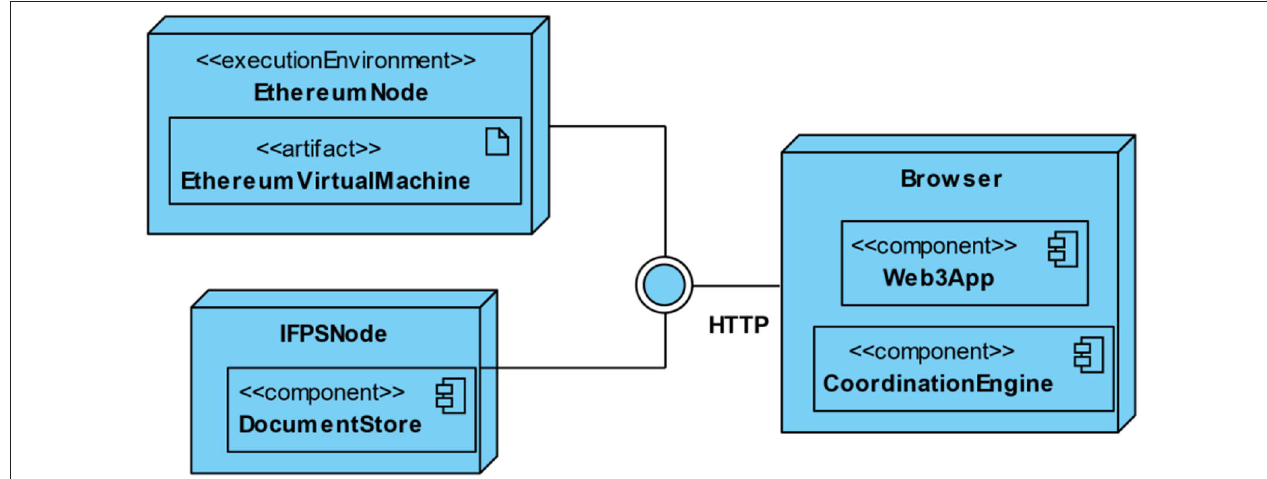
FIGURE 4 | A deployment diagram depicting the overall architecture of the proposed